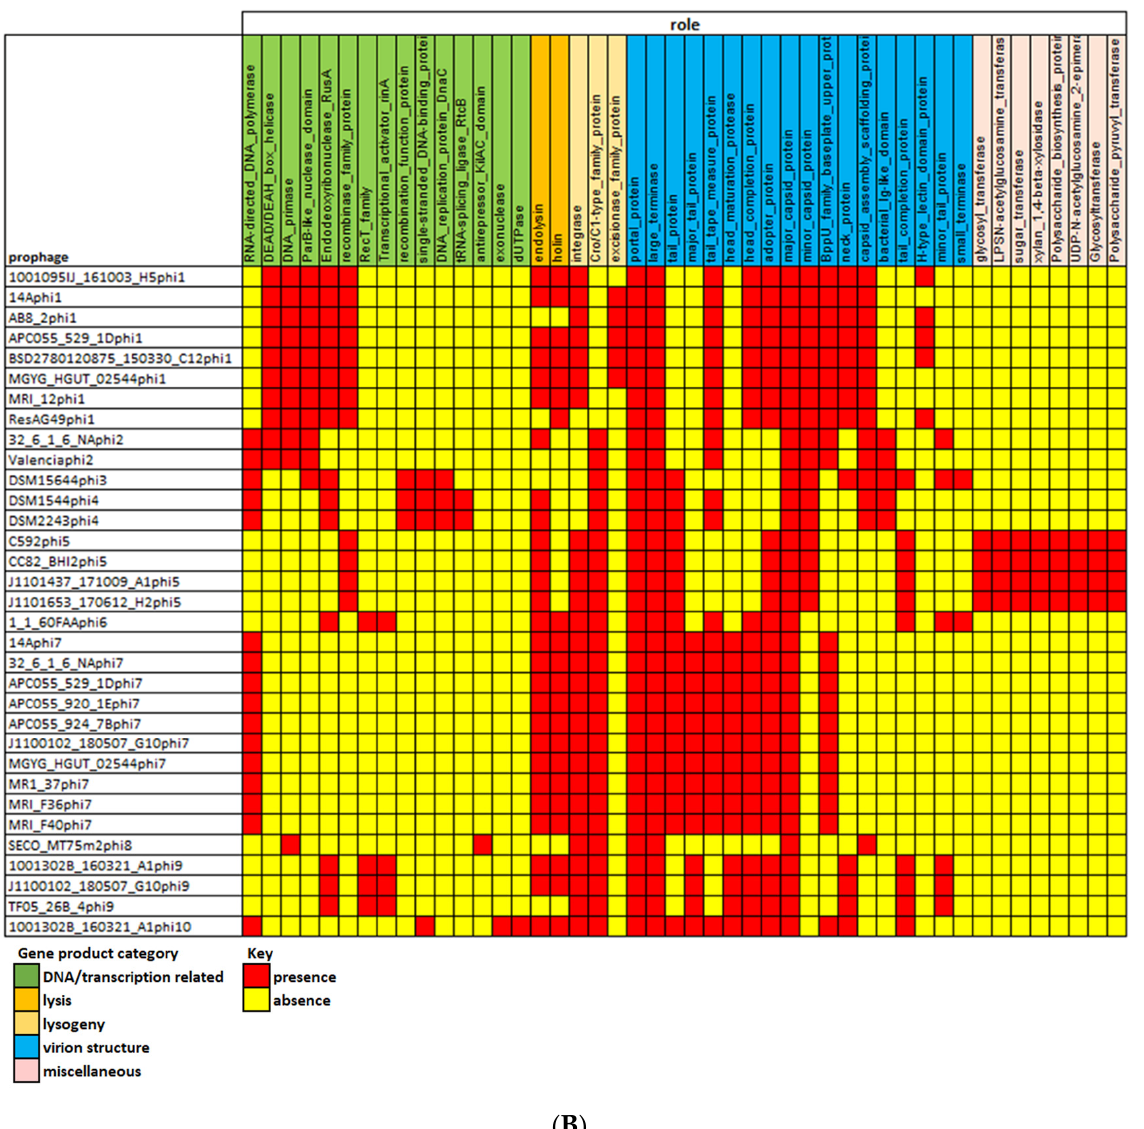
Figure 4. ( A ) Heatmap showing the distribution (presence–absence of OGs among prophages of E. lenta . ( B ) Heatmap illustrating genes detected among E. lenta prophages found with a particular function.